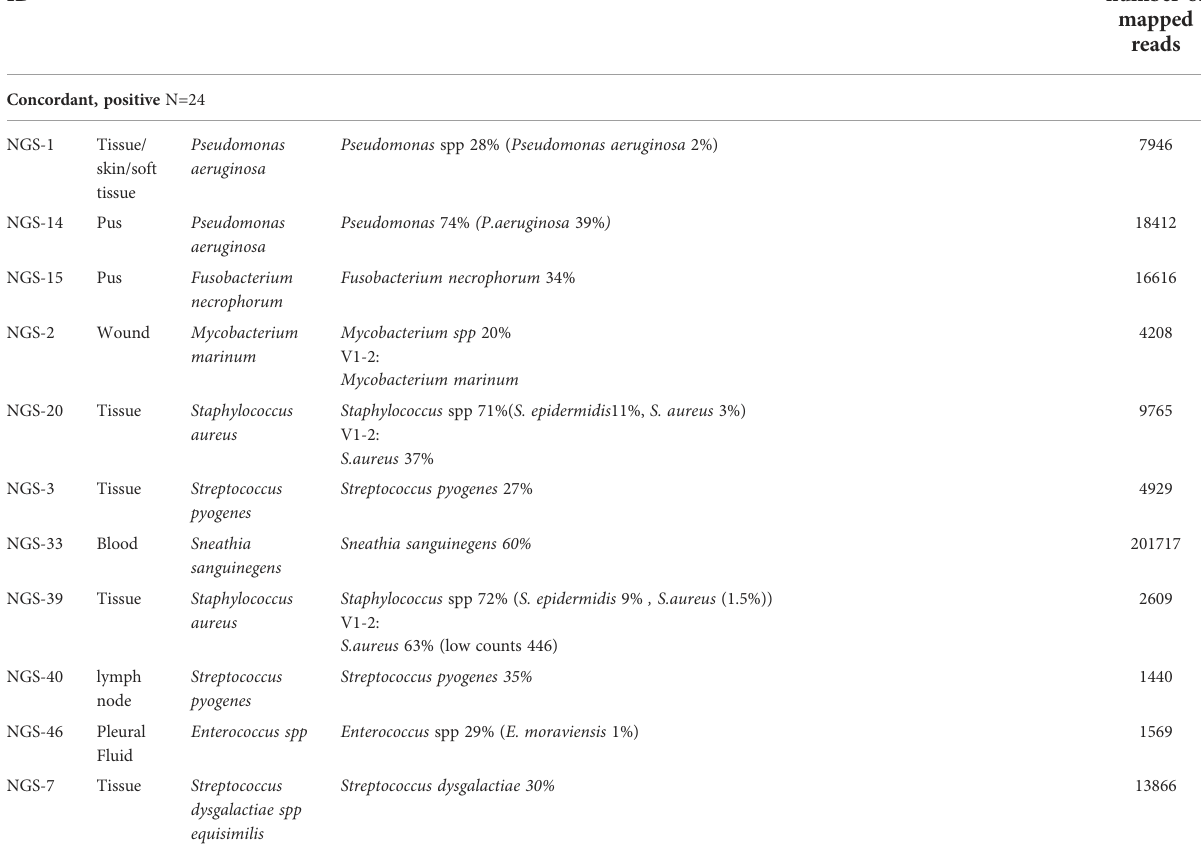
TABLE 1 Comparison between Sanger and NGS results. Sample Material Sanger results NGS results Total ID